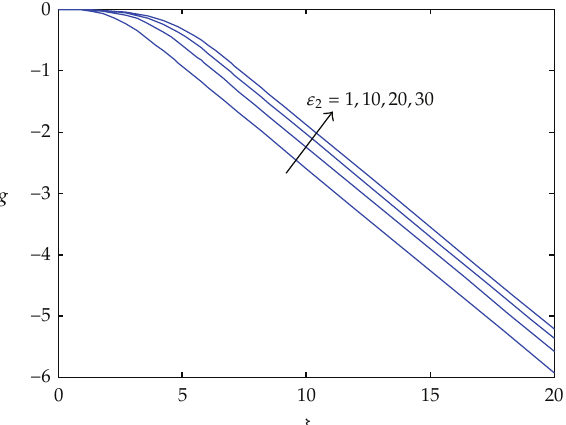
Figure 4: E ff ect of ε 2 parameter on the similarity function g related to the y component of velocity (cid:7) ε 1 (cid:5) 1, n (cid:5) 2 (cid:8)